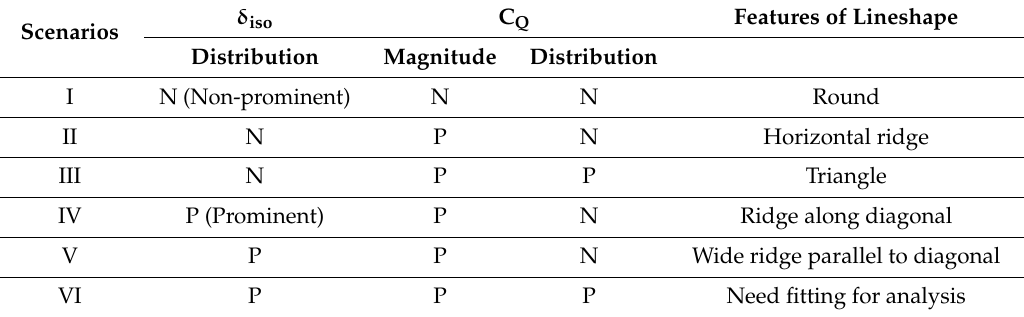
Table 1. Six scenarios of regular lineshapes in MQMAS spectrum determined by combinations of “distribution of δ iso ”, “distribution of C Q ” and “magnitude of C Q ”. “N” stands for non-prominent (does not mean “not exist”), “P” stands for prominent. The key feature of each pattern is also commented. Examples of real spectra are shown in Figure